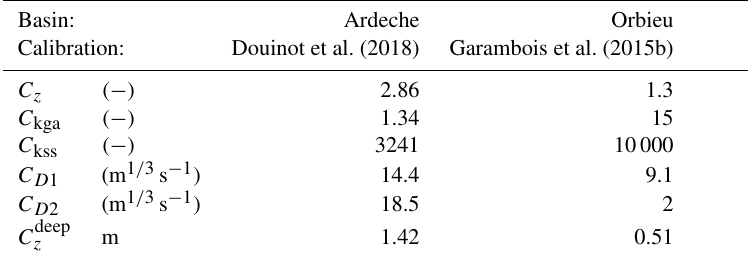
Table 3. Calibrations obtained by Douinot et al. (2018) and Garambois et al. (2015b) for the Orbieu catchment in Lagrasse and the Ardeche catchment in Vogue. Shown are the multiplier coefficient for soil depth maps ( C z ), the multiplier coefficient for the spatialized saturated hydraulic conductivity used in lateral flow modeling ( C kss ), the multiplier coefficient for the spatialized hydraulic conductivity at saturation that is used in infiltration modeling ( C kga ), two friction coefficients for low- and high-water channels ( C D 1 and C D 2 ), and the deep layer depth for the SSF–DWF model ( C deep z ). Basin: Ardeche Orbieu Calibration: Douinot et al.